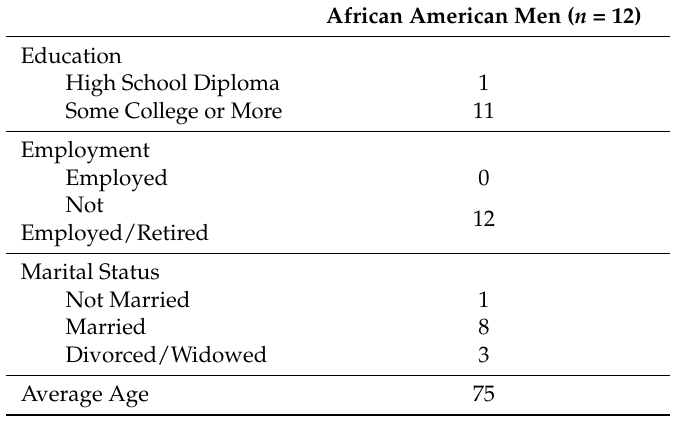
Table 1. Sociodemographic characteristics of Older African American men with type 2 diabetes ( n =